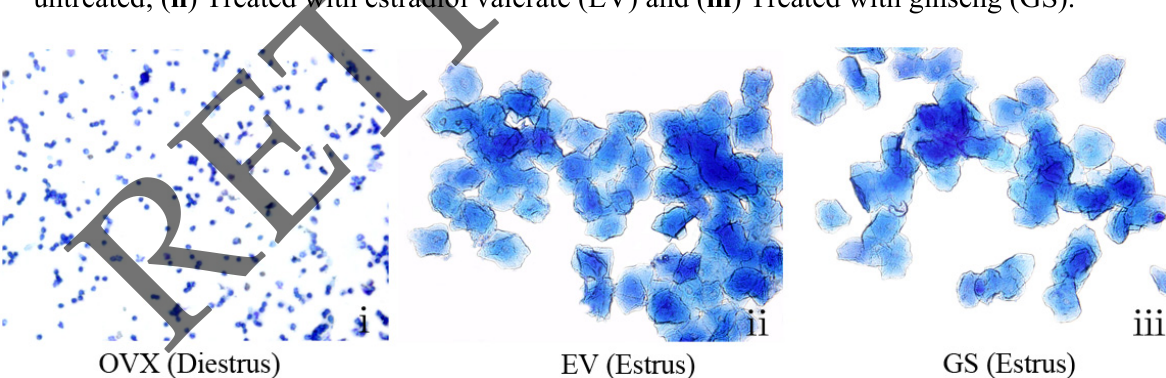
Figure 2. The effect of ginseng (GS) on the estrous cycle. ( i ) Ovariectomized (OVX) mice untreated; ( ii ) Treated with estradiol valerate (EV) and ( iii ) Treated with ginseng (GS).